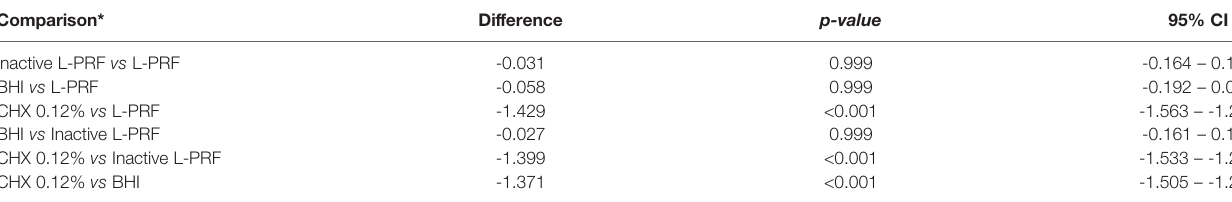
TABLE 3 | Comparisons of effects of the tested solutions on P. gingivalis in pre-formed multi-species bio fi lm experiments.